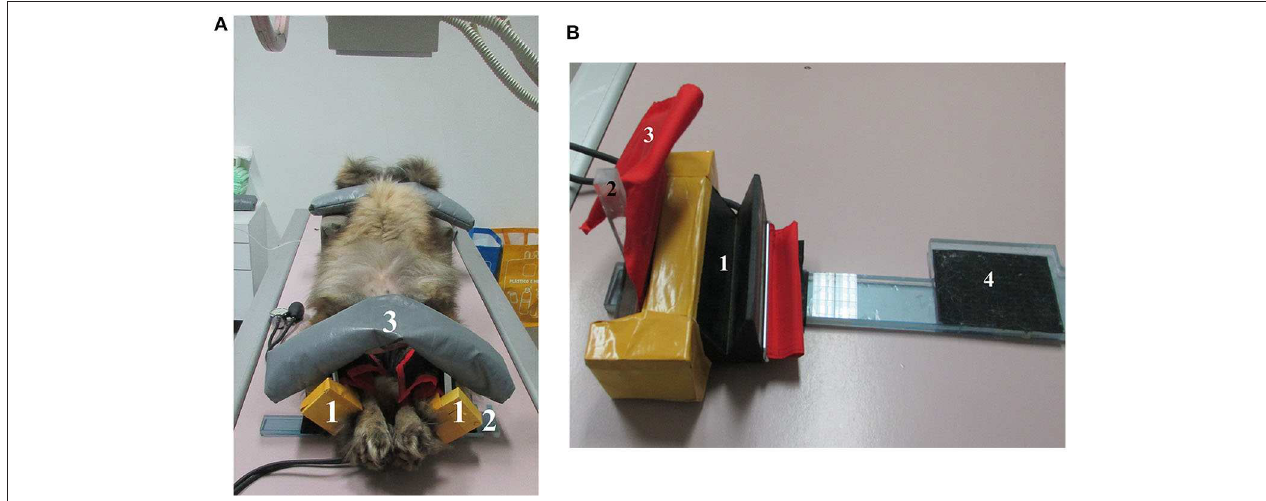
FIGURE 1 | (A) Estrela mountain dog, female, sedated on an X-ray table to obtain the hands-free ventrodorsal hip extended view. (1) Holder device to fix both hind limbs in dog tarsus, (2) acrylic base coated with self-adhesive Velcro, (3) cylindrical sandbag. (B) Holder device to fix the dog’s tarsus. (1) Rubber groove to accommodate the dog tarsus, (2) acrylic stem that will be attached to the contralateral to maintain hind limb medial rotation, (3) sphygmomanometer to fix the tarsus firmly in rubber groove, (4) acrylic base coated with self-adhesive Velcro to maintain the holder device in